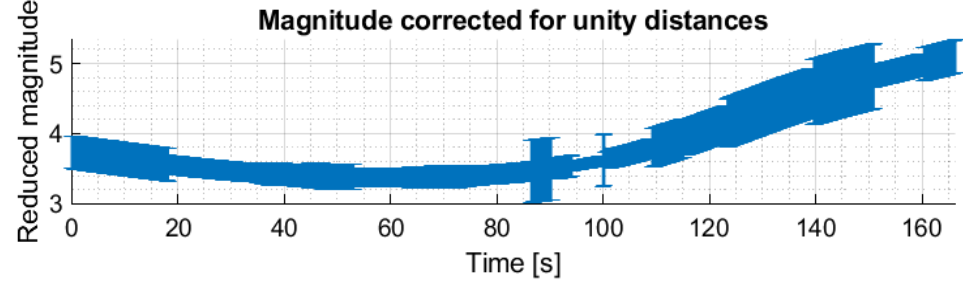
Figure 9. Observed light-curve of CZ-4C R/B (SSN 40879) taken the 20th of July 2020 from SCUDO observatory.